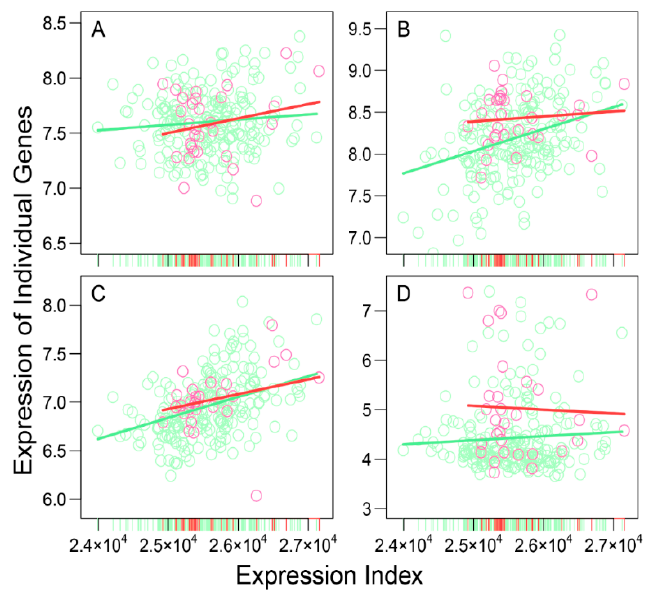
Figure 1. Allometric change in the expression level of four randomly chosen genes, AATK ( A ), AKAP11 ( B ), CD8A ( C ), and CDH9 ( D ), with expression index (EI) for low-risk (red) and high-risk patients (green). A dot denotes the observed expression value of a given gene in a sample, plotted over the EI of the sample, and a line represents the fitness of power equation to the EI-varying pattern of gene expression. The ticks at the x -axis indicate the EI of samples.